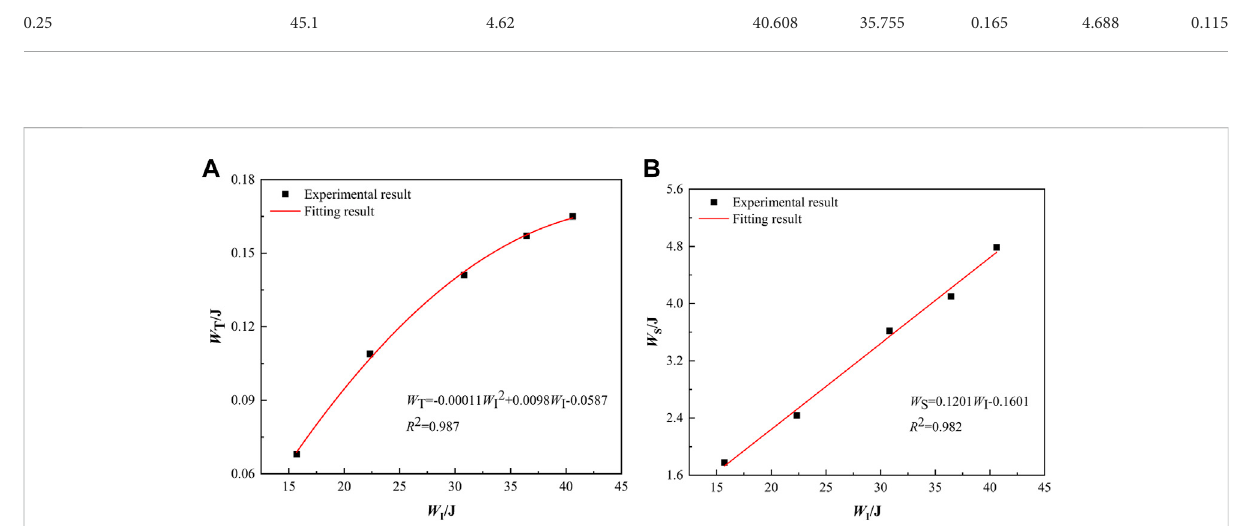
FIGURE 10 Energy relation curve. (A) Relationship between W I and W T , (B) Relationship between W I and W S .